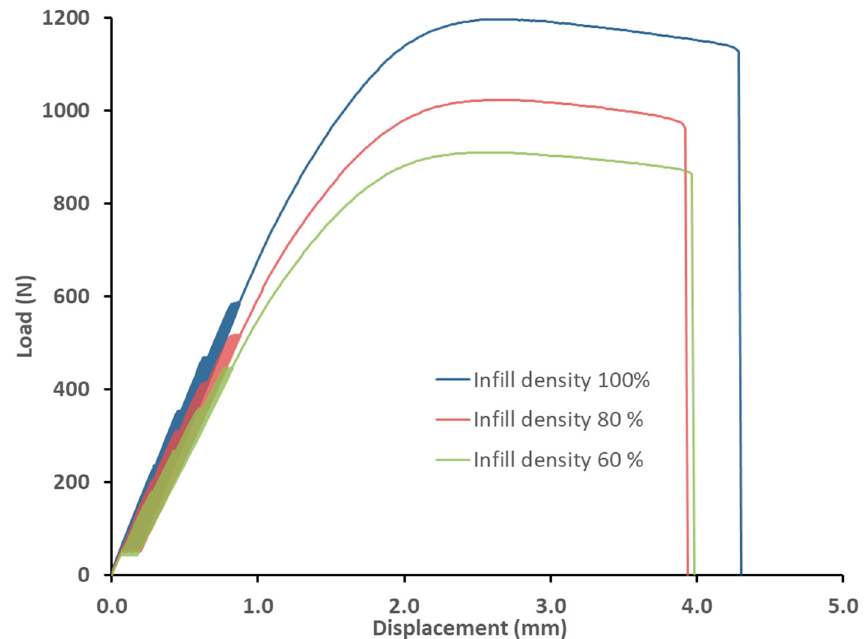
Figure 9. Influence of infill density on low-cycle fatigue using FDM 3D printing with a 0.6 mm nozzle diameter.